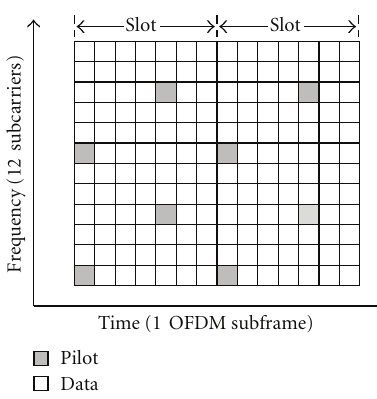
Figure 5: LTE reference pilot